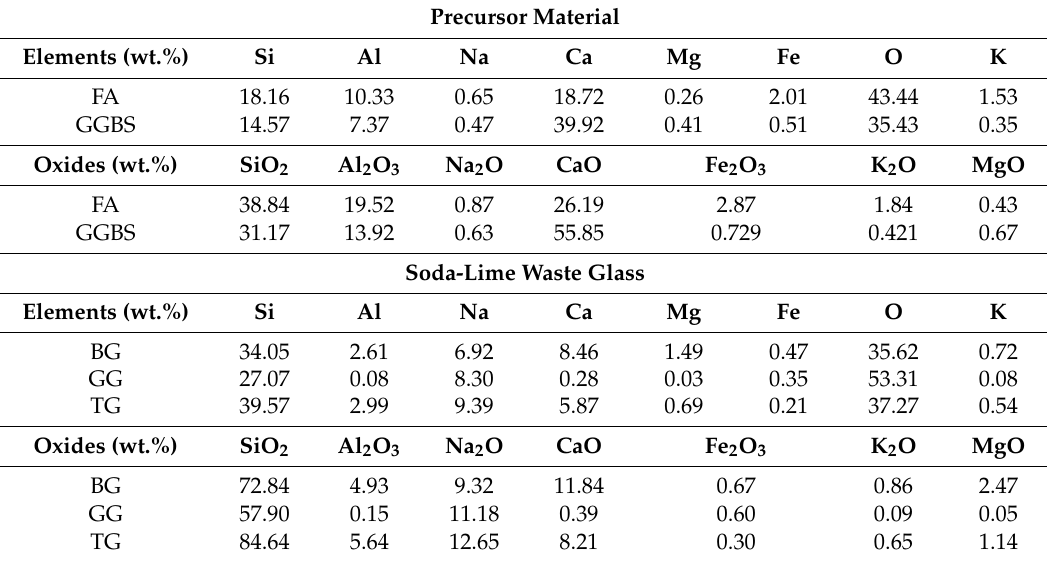
Figure 1. Particle size distribution of fly ash (FA) and ground granulated blast furnace slag (GGBS). Table 1. Chemical composition of precursor materials and glass of three di ff erent